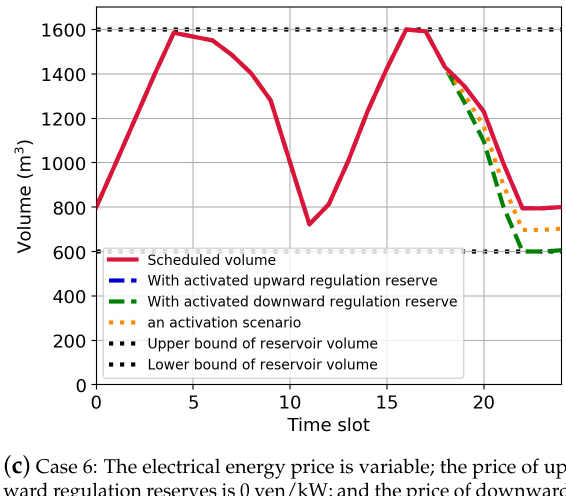
( c ) Case 6: The electrical energy price is variable; the price of up- ward regulation reserves is 0 yen/kW; and the price of downward regulation reserves is 20 yen/kW ( t = 18,...,20). Figure 10. Results for the volume of the reservoir under the variable electrical energy prices. The blue and green dashed lines show the change in water storage volume when the provided regulation reserve capacities are fully activated. The yellow dotted line represents a changed scenario in the water storage volume when the provided regulation reserves are activated for only half the time in each time slot.